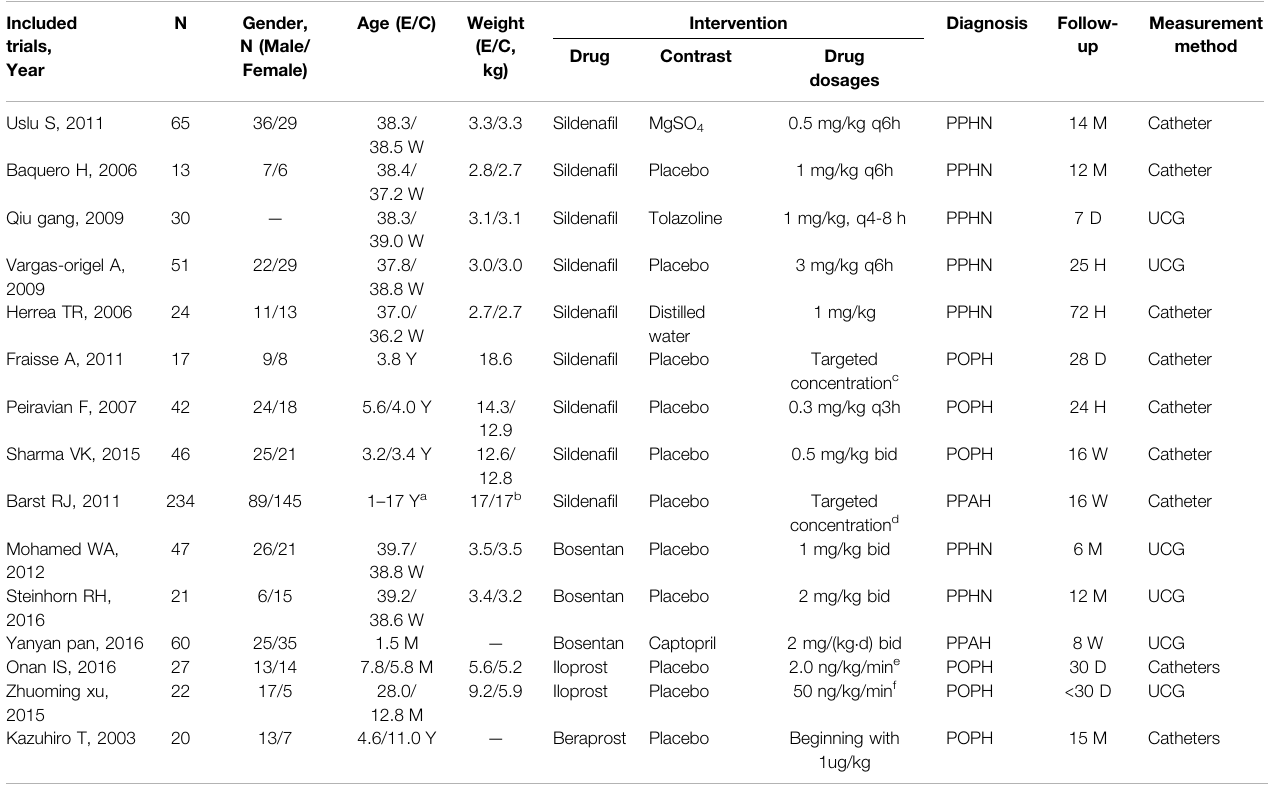
TABLE 1 | The characteristics of the included studies. Included trials,